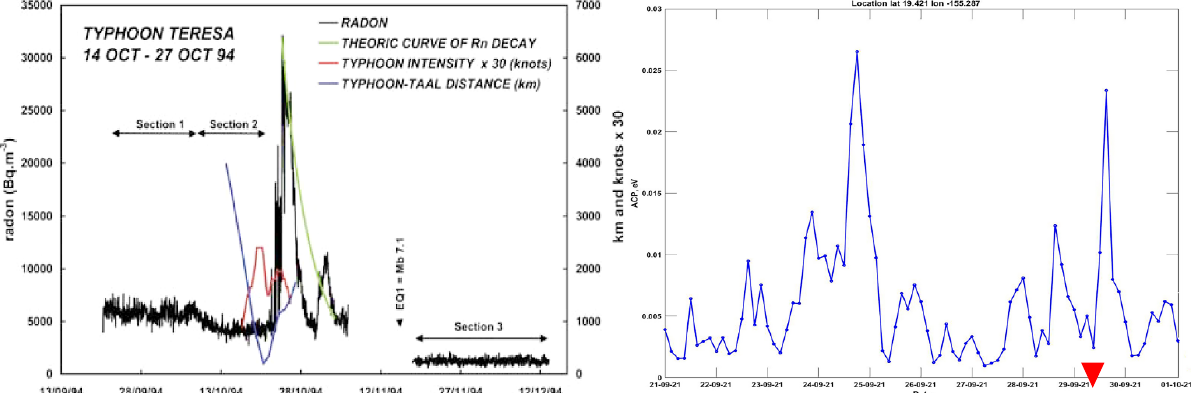
Figure 7. Left panel—radon anomaly (black) and typhoon Teresa (October 1994): intensity (red) of the typhoon (knots) and distance (km) between the typhoon and the Taal volcano (blue) are displayed together with radon concentration in soil gas. Green curve is the theorical radioactive decay of radon starting at the peak of the anomaly; Right panel—ACP variation over the caldera of K ī lauea volcano around the time of volcano eruption on 29 September 2021 marked by red triangle.